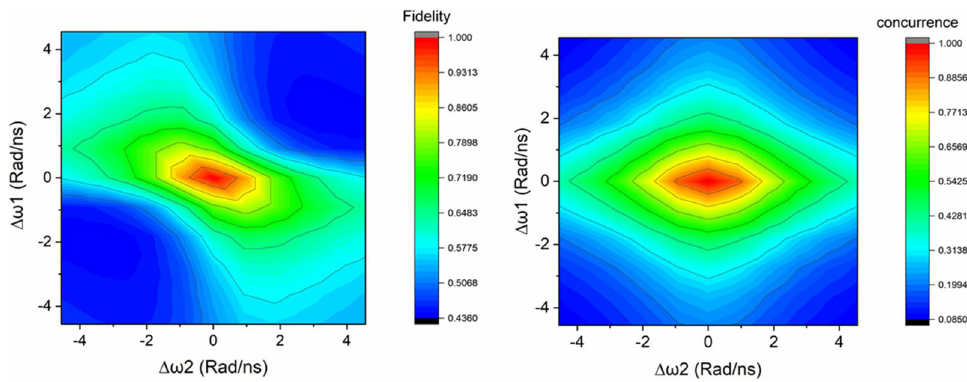
Figure 4. Fidelity (left) and Concurrence (right) of the state obtained after the compensation scheme for a dot with an FSS of 3 µeV, as a function of the errors �ω 1 and �ω 2 . All of the other time-independent phase terms are assumed to be 1 for